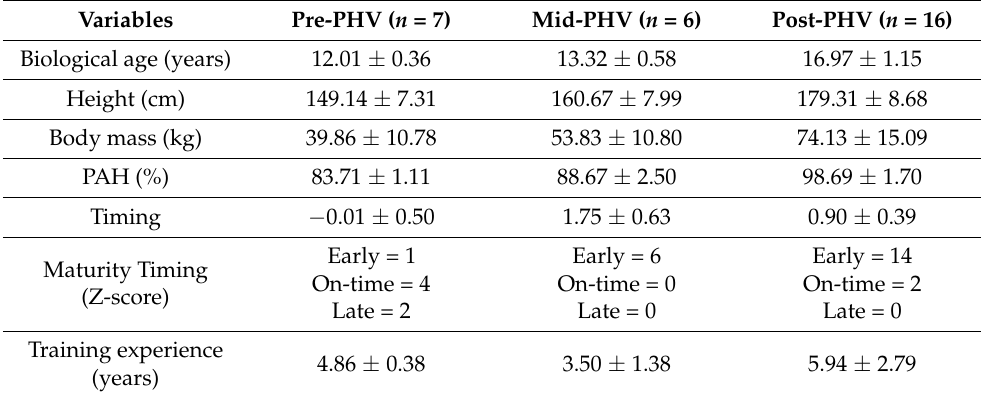
Table 1. Descriptive data of the subjects (Mean ±